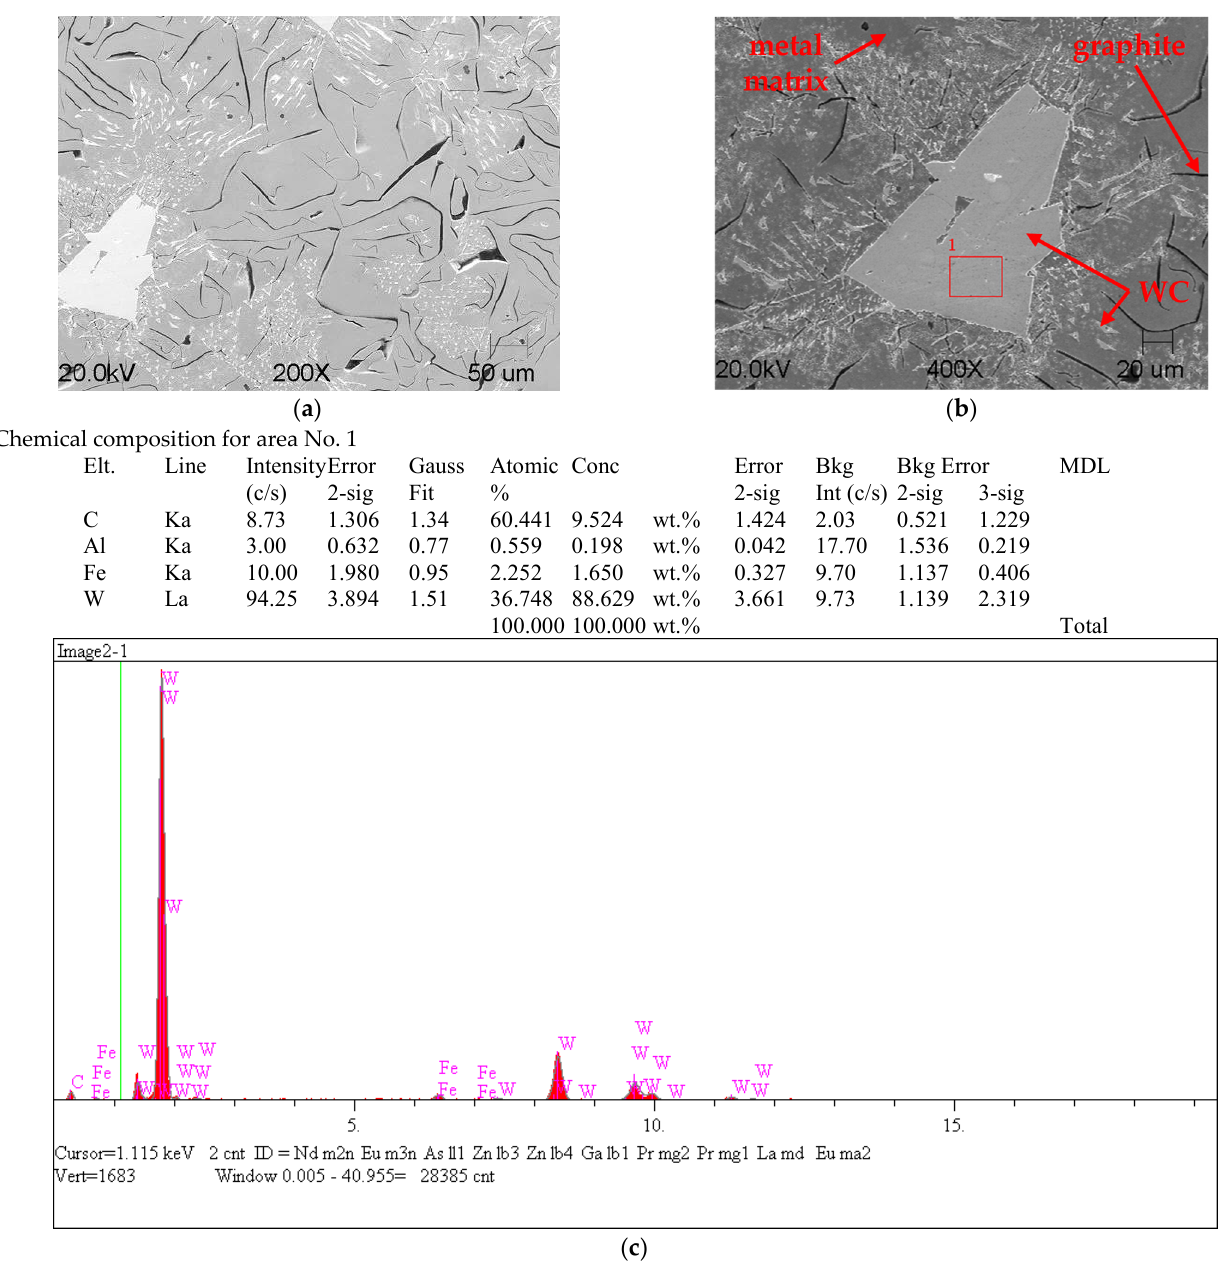
Figure 8. SEM microstructure of high-aluminum cast iron with the addition of tungsten ( a , b ) and EDS X-ray microanalysis of carbide precipitation with a chemical analysis of tungsten carbide ( c ).